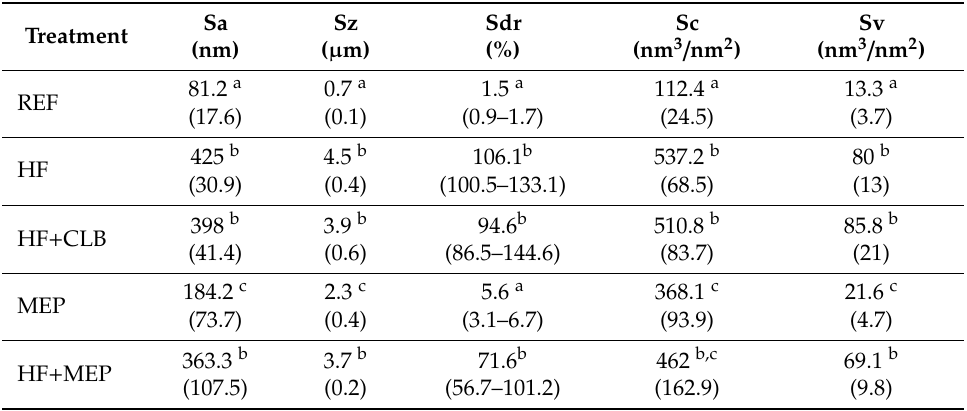
Figure 8. 3D-profilometric images (40 × magnification) of the polished lithium disilicate ceramic before (REF, 1.14 µ m amplitude range) and after treatments with HF (8 µ m amplitude range), HF + CLB (7.01 µ m amplitude range), MEP (4.18 µ m amplitude range), and HF + MEP (5.5 µ m amplitude range). Table 2. Results of roughness measurements